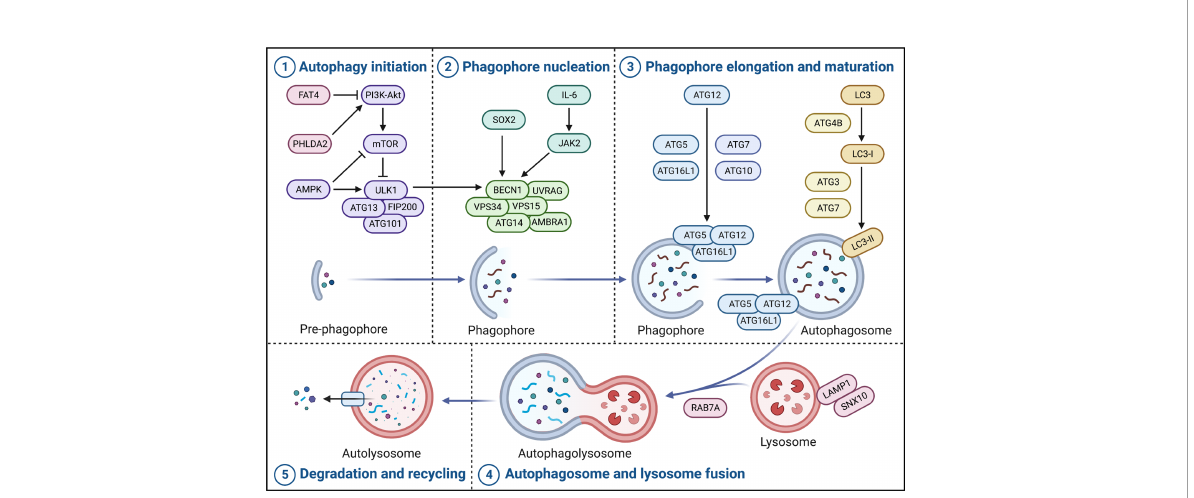
FIGURE 1 Crucial pathways of autophagy in CRC. Autophagy in CRC broadly contains fi ve stages, namely autophagy initiation, phagophore nucleation, phagophore elongation and maturation, autophagosome and lysosome fusion, and autolysosome degradation and recycling. The ULK complex (ULK1-ATG13-FIP200-ATG101) triggers autophagy initiation and the PI3K complex (BECN1-VPS34-VPS15-ATG14-AMBRA1-UVRAG) promotes phagophore nucleation. Moreover, phagophore elongation and maturation contain two important ubiquitination modi fi cations, one of which is the formation of complexes and localization of ATG5, ATG12, and ATG16L1 to the autophagosome membrane catalyzed by ATG7 and ATG10; the other is the cleavage of LC3 precursor protein by ATG4B and ATG7 to generate LC3-I, and the ATG5-ATG12-ATG16L1 complex catalyzes LC3-I coupling with PE to form LC3-II. Subsequently, RAB7A and LAMP1 are involved in autophagosome and lysosome fusion to form autolysosome. Finally, the contents of the autolysosome are degraded and recycled into the cytoplasm to re-engage in cellular